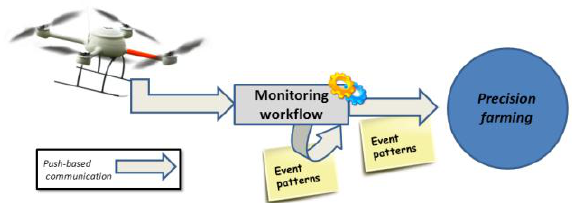
Figure 7: Event-driven architecture for monitoring